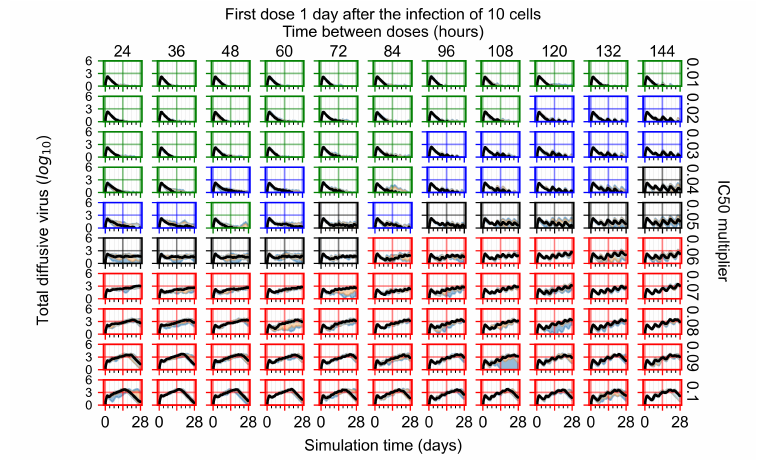
Figure A113. Extracellular diffusive virus quantities (arbitrary units), Y axis in log scale, and exponent values as tick marks.